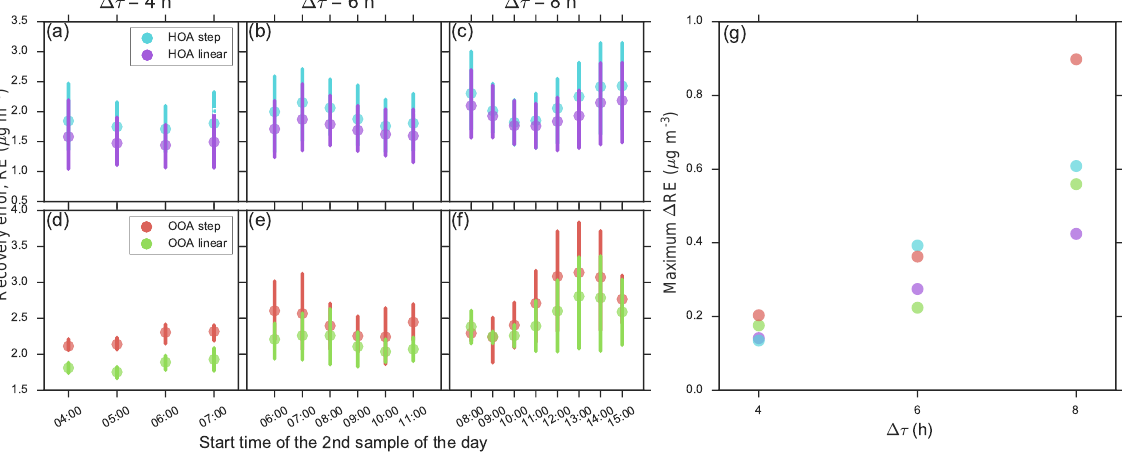
Figure 6. (a) – (f) Mean recovery error (RE) as a function of the start time of the second sample of the day for HOA and OOA time series constructed by step and linear interpolation between sequential measurements of length ( (cid:49)τ ) 4, 6, and 8h. κ m = 20% and T = 57h, meaning each data point is an average over 4 ( = 228 / 57) time series segments. The start time of the second sample of the day represents the 4, 6, and 8 unique sequential sampling schedules that are possible with 4, 6, and 8h samples, respectively (Sect. 4). The vertical bars represent 95% confidence intervals determined by bootstrapping the mean estimates. (g) Maximum (cid:49) RE vs. (cid:49)τ . Maximum (cid:49) RE represents the maximum difference in RE between two unique sampling schedules for a given (cid:49)τ . It is the maximum possible potential error that may be incurred if a suboptimal sampling schedule is chosen for a given type of time